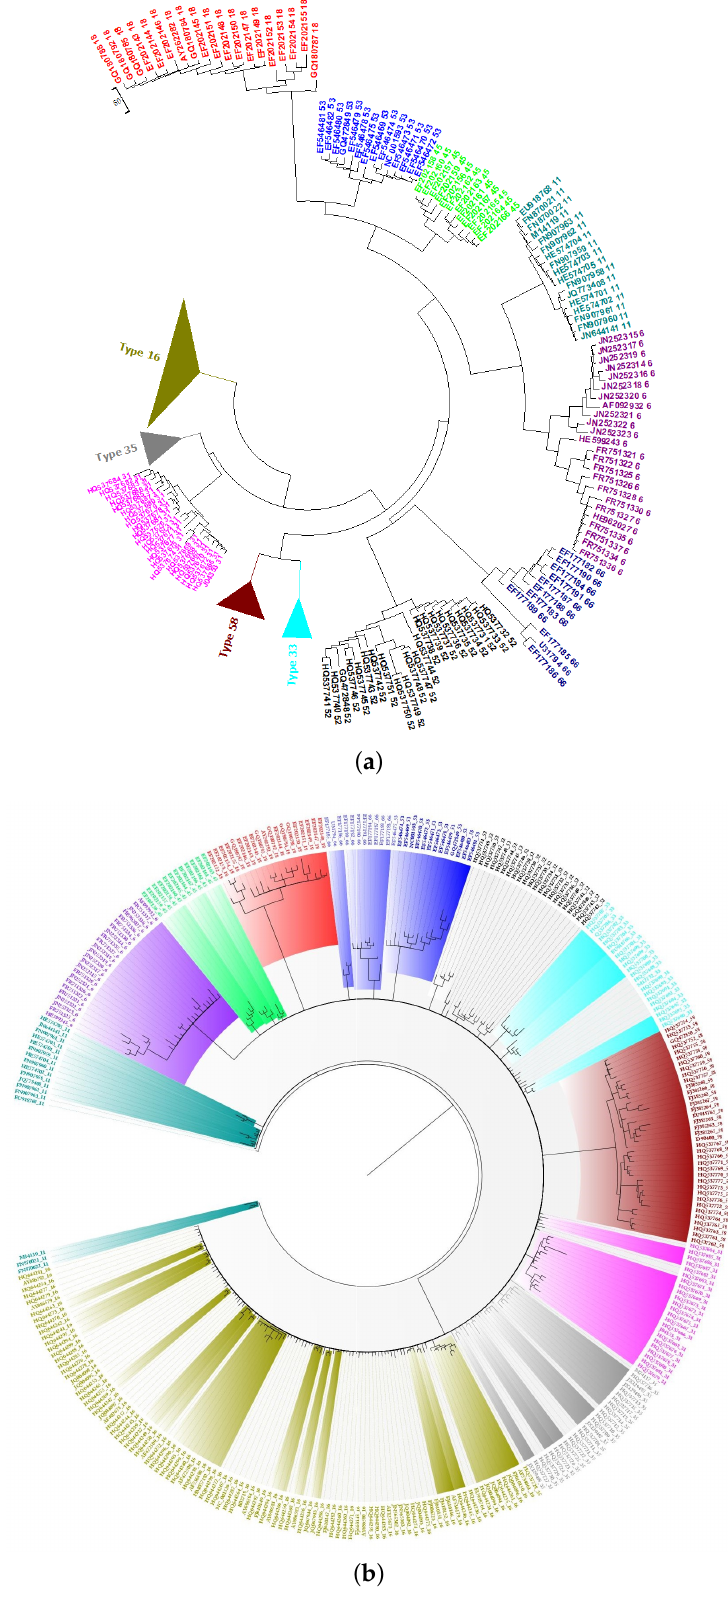
Figure 4. ( a ) The Neighbor-Joining phylogenetic tree of 326 HPV genome sequences based on PCNV method. ( b ) The phylogenetic tree of 326 HPV genome sequences based on Bayesian inference